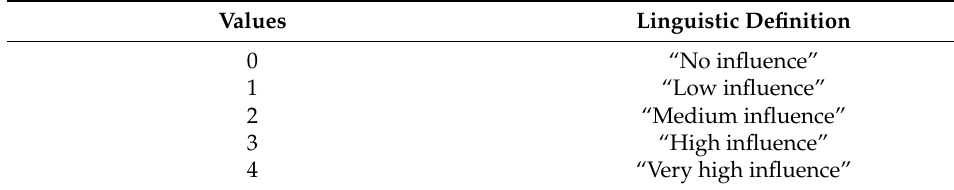
Table 1. Defined influence scale in DEMATEL technique.